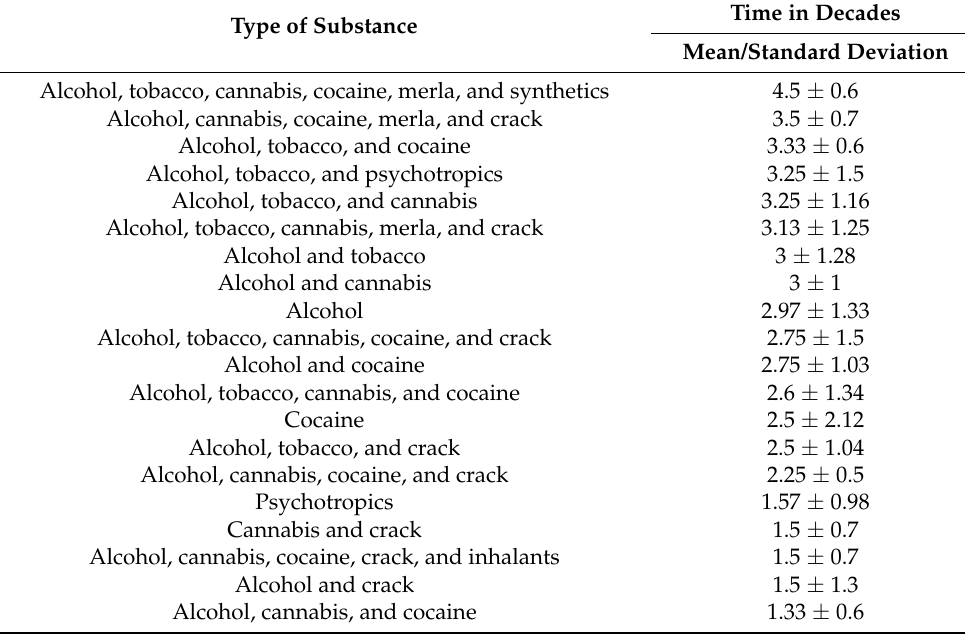
Table 3. Time of consumption of several drugs and their associations among the elderly assisted by the CAPS-AD from DF between 2000 and